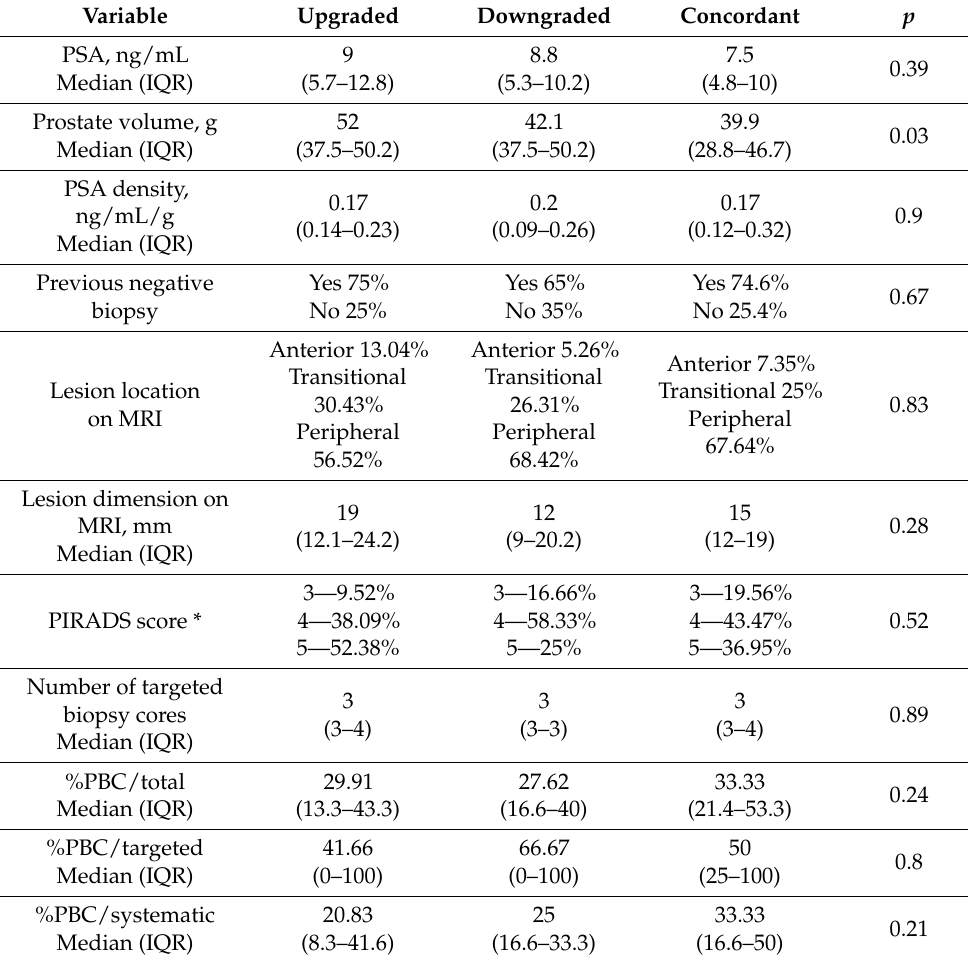
Table 3. Comparison between the characteristics of patients who were upgraded, downgraded, and concordant in terms of GG with final